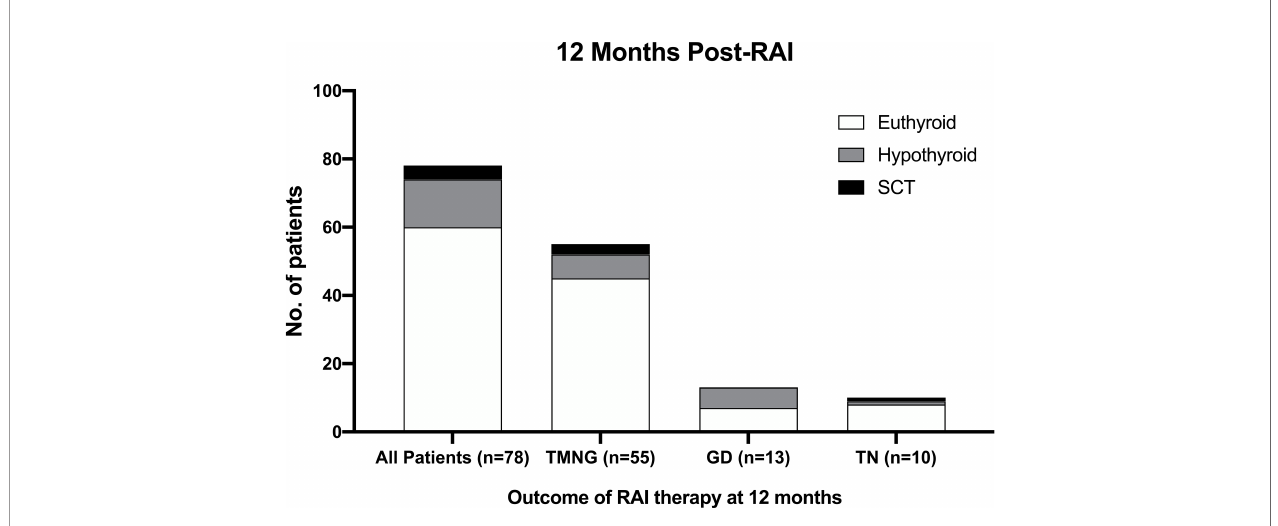
FIGURE 3 | Outcome for SCT patients 12-month post-RAI